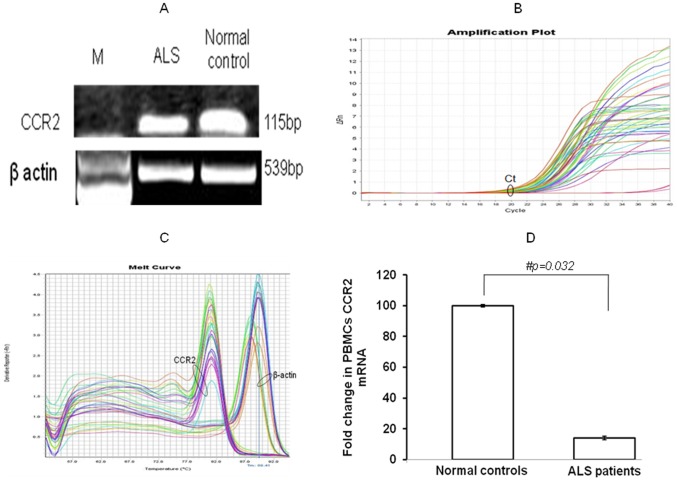
Real Time PCR analysis of relative mRNA expression of CCR2 in PBMCs of subjects.(A) Agarose gel electrophoresis of Real Time PCR products of target gene CCR2 and endogenous control β-actin. Reactions were performed with mRNA isolated form PBMCs of ALS patient and normal control. (B) Representative amplification curves depicting increase in fluorescence of CCR2 and β-actin from cDNA of same sample. No increment in fluorescence of negative controls was observed. The x-axis indicates cycle number and the y-axis shows intensity of relative fluorescence in linear scale. Ct is threshold cycle where normalized fluorescent signal of SYBR green intersect with threshold line. (C) Melt curve profile of Real Time PCR products of CCR2 and β actin clearly indicates the absence of any non specific amplification. The x-axis indicates negative derivative of change in amount of fluorescence per unit change in temperature (dF/dT) and the y-axis represents temperature in Celsius (°C). (D) Bar diagram showing fold change in CCR2 mRNA expression PBMCs from ALS and normal subjects. Values are plotted as mean ± SE (Standard error). Data was analyzed by unpaired, independent 2-tailed student t test with equal variance. # indicates significant difference among the groups (p<0.05). Expression of CCR2 were normalized to expression of endogenous control β-actin. ALS, amyotrophic lateral sclerosis; CCR2, chemokine receptor 2; PBMCs, peripheral blood mononuclear cells.